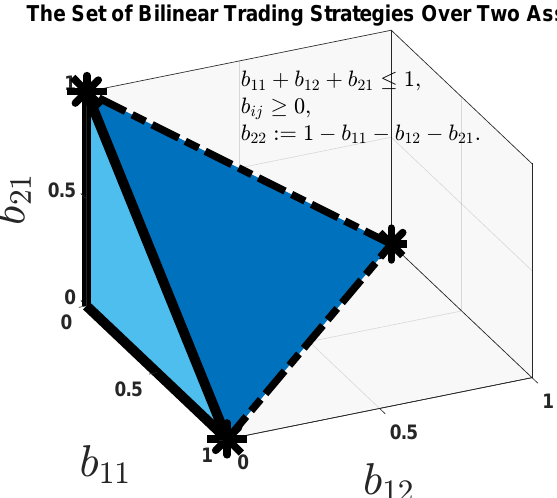
(cid:104) (cid:105) b ij 2 × 2